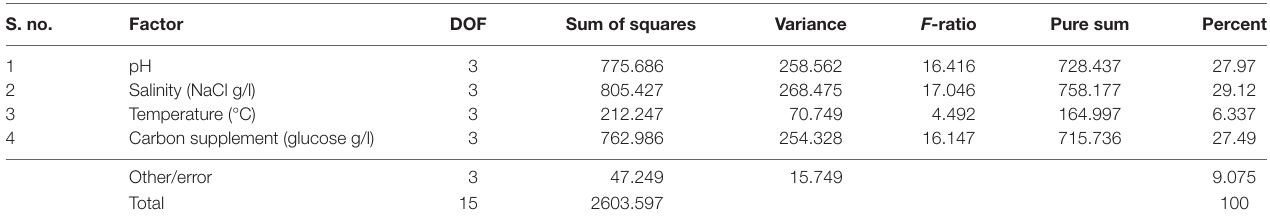
TaBle 7 | analysis of variance (anOVa) for total lipids production. s.